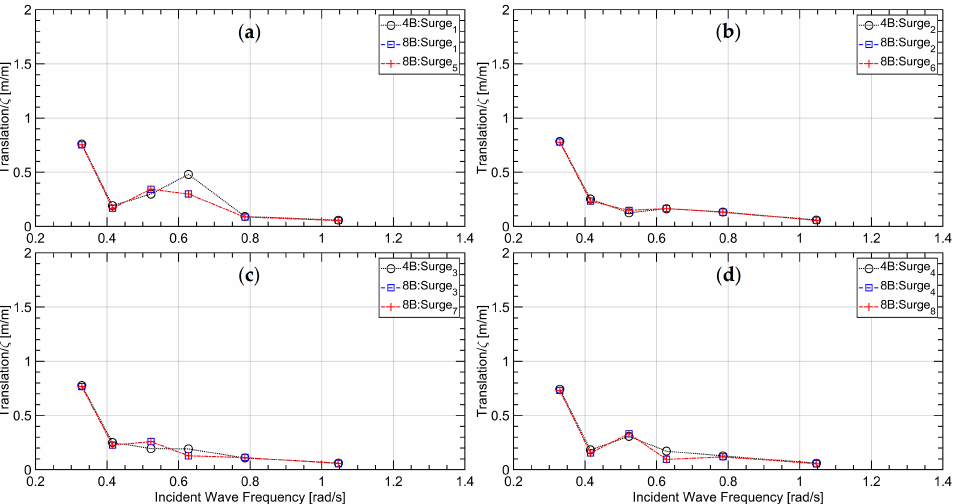
Figure 17. RAOs of surge response for studying the sensitivity to module arrangement, where n B denotes the configuration with n bodies; subscript n , the corresponding n -th body’s motion response: ( a ) the 1st and 5th modules; ( b ) the 2nd and 6th modules; ( c ) the 3rd and 7th modules; (d) the 4th and 8th modules.